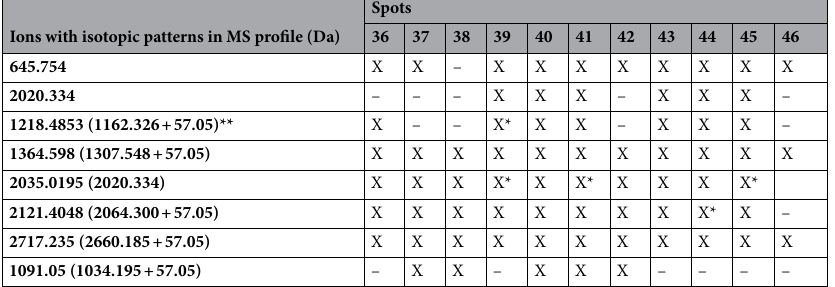
Table 2. Ions with isotopic patterns in the mass spectrometry profile of the 11 spots identified as kallikreins in the seminal plasma of stallions throughout the climatic seasons. Four spots were identified as Kallikrein-1E2 and validated by Scaffold (39, 41, 44 and 45), and another seven spots were identified by comparing the general protein profiles obtained (peak list) with the mass values of the tryptic peptides that were recovered from theoretical cleavage of Kallikrein-1E2 by trypsin, using the PeptideMass software. *Represents the peptide sequence recovered from MS analysis. **The value 57.05 Da was added to the peptides when alkylation by acetamide